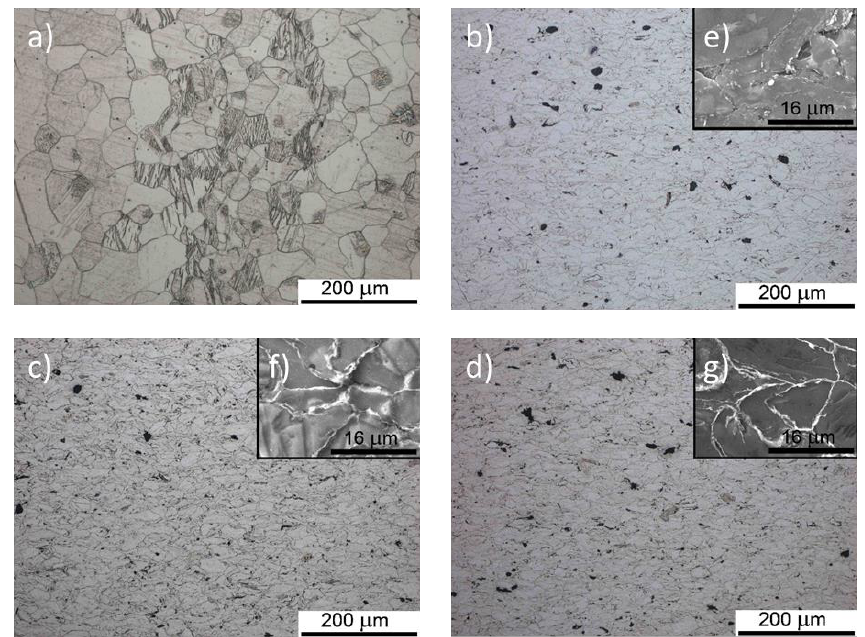
Figure 2. Microstructure of wrought Mg and Mg CS; LM and SEM detail; etched by 5% Nital: ( a ) wrought pure Mg; ( b ) 500 MPa/RT; ( c ) 100 MPa/400 °C; ( d ) 500 MPa/400 °C; ( e ) detail of 500 MPa/RT; ( a ) wrought pure Mg; ( b ) 500 MPa/RT; ( c ) 100 MPa/400 ◦ C; ( d ) 500 MPa/400 ◦ C; ( e ) detail of ( f ) detail of 100 MPa/400 °C; ( g ) detail of 500 MPa/400 °C. 500 MPa/RT; ( f ) detail of 100 MPa/400 ◦ C; ( g ) detail of 500 MPa/400 ◦